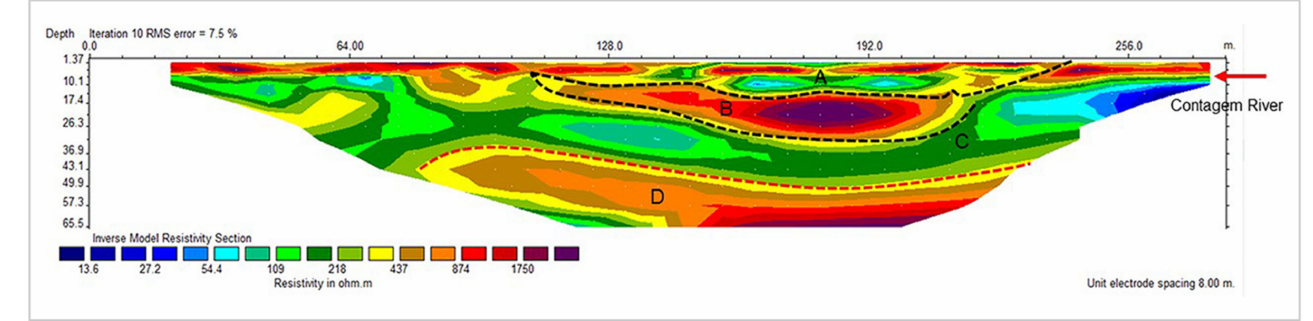
Figure 6. Internal architect of a shallow rain triggered Sobradinho LS indicating: ( A ) hypothetical landslide boundary, ( B ) compacted and dry landslide material might be labeled with previous landslide slip surface, ( C ) a continuous low resistivity material might be related with a possible permeable path through the water, and ( D ) Saprolite layer. The color scale represents resistivity values in ohm.m (adopted after permission from ref. [25]).